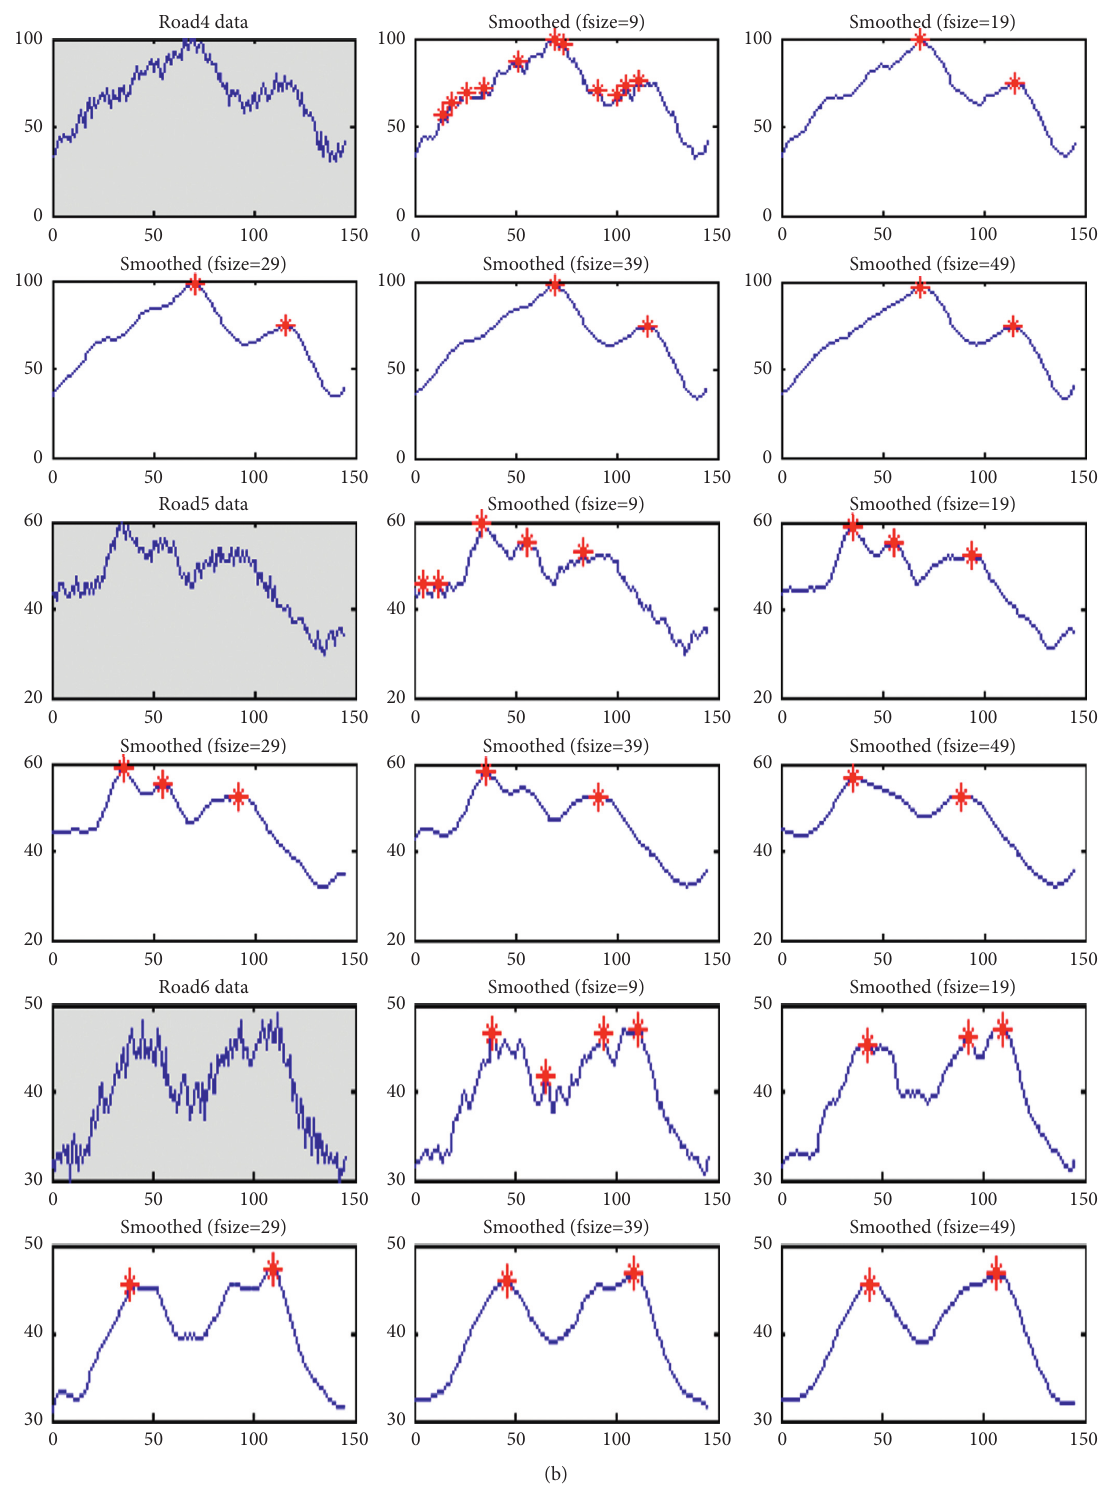
Figure 17: The data smoothed by Savitzky–Golay filter and the peaks